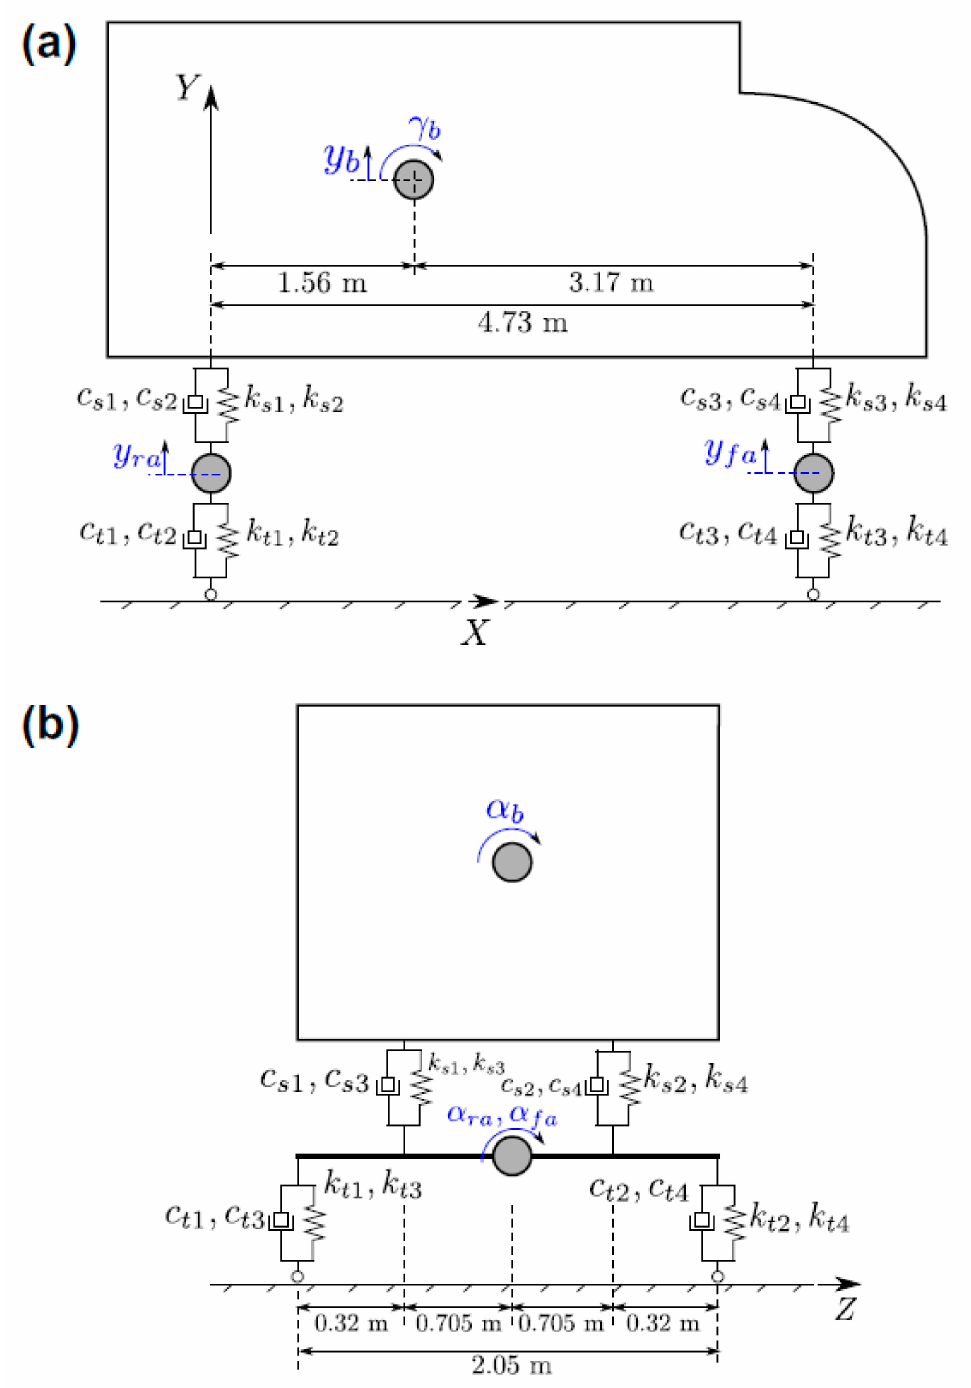
Figure 11. Truck model: ( a ) side view, ( b ) rear